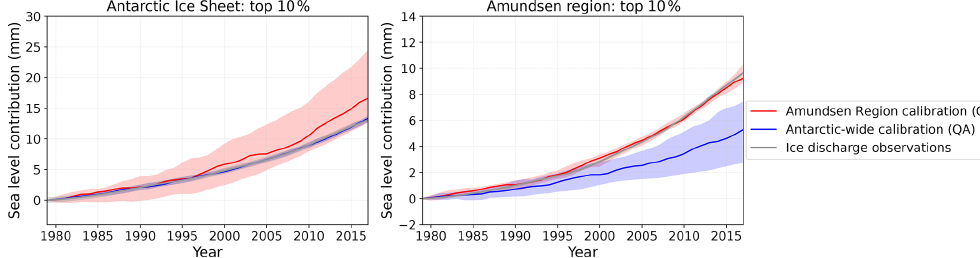
Figure A1. Similar as Fig. 6, but for the top 10% best-performing ESM-RF pairs.